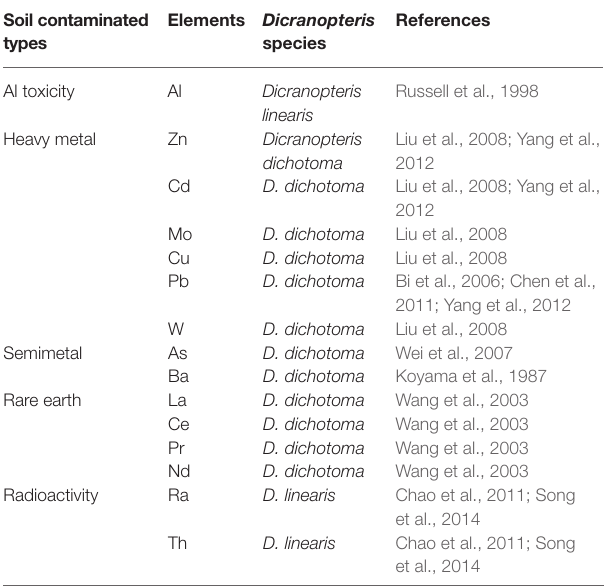
TABLE 1 | Soil contaminated types and elements accumulated by Dicranopteris